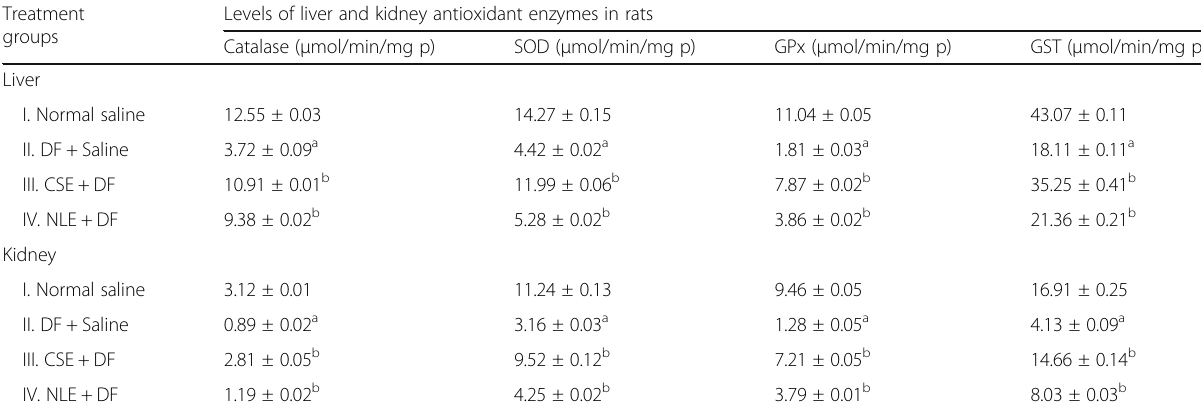
Table 2 Effect of CSE and NLE on liver and kidney antioxidant enzymes activities in DF-exposed rats Treatment Levels of liver and kidney antioxidant enzymes in rats groups